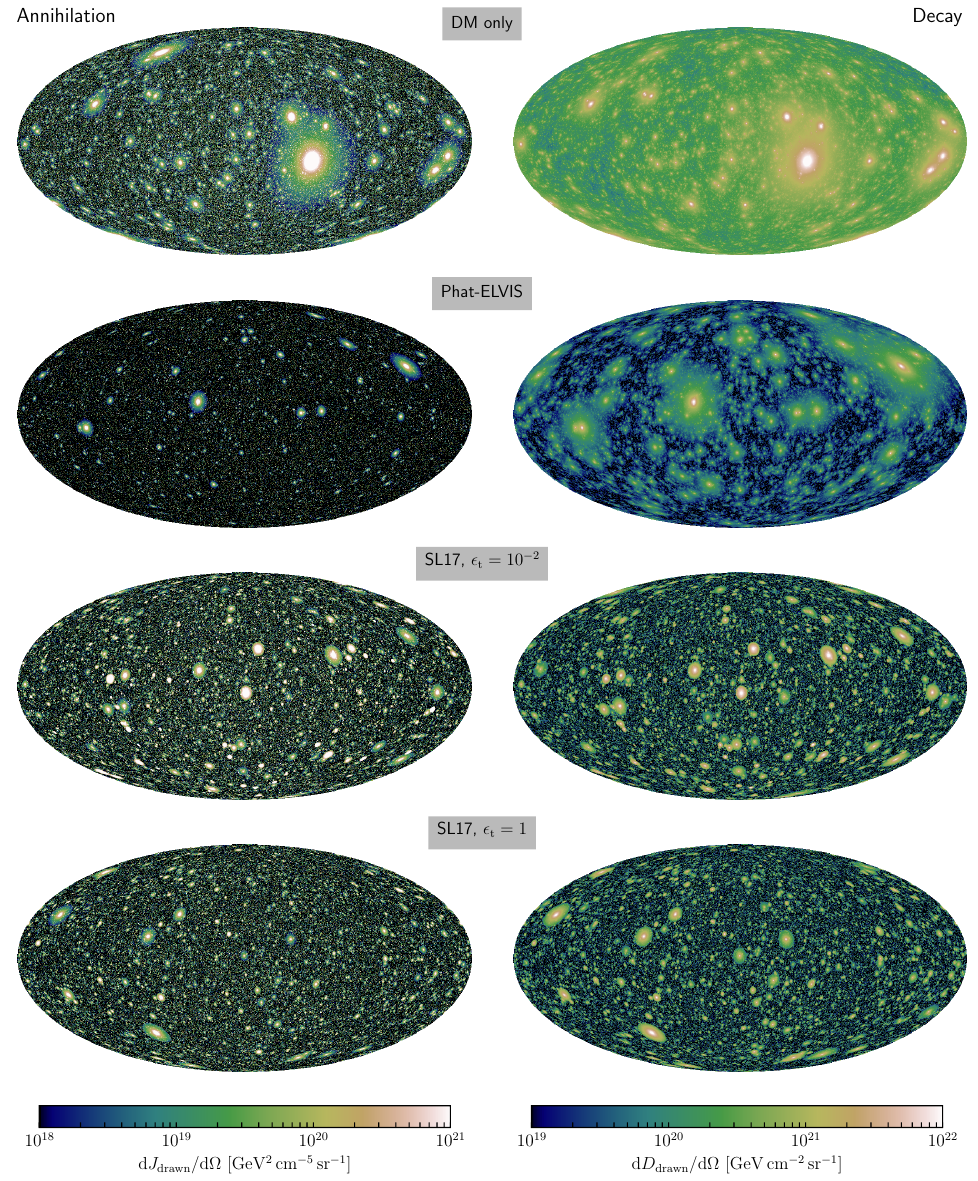
Figure 4. One random realization of the Galactic DM subhalo sky (all subhalos above 10 4 M the smooth contribution) in case of annihilation ( left ) or decay ( right ), derived from the models gathered in Table 1. Maps are drawn in galactic coordinates (Mollweide projection) with ( l , b ) = ( 0,0 ) at their centers. ( From top to bottom ): Model #1 emulating numerical DM-only simulations (1,214,313 drawn halos); model #2 emulating the Phat-ELVIS simulations [10] (364,064 drawn halos); and the semi-analytical models #3 (subhalos more resilient against tidal disruption, 549,572 surviving halos) and #4 (less subhalos surviving tidal destruction, 546,096 surviving halos) according to SL17 [15]. The displayed maps ( fits format, 50 MB in file size) can, along with their subhalo catalogs, be provided upon request. In Appendix A, we list some properties of the brightest objects in these